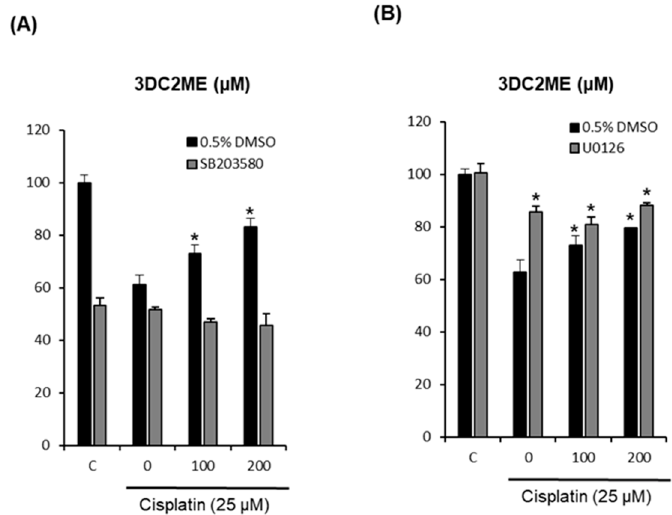
Figure 5. Effects of ( A ) SB203580 and ( B ) U0126 on the protective effects of 3DC2ME in cisplatin-induced cytotoxicity in LLC-PK1 cells. An MTT assay was performed on LLC-PK1 cells exposed to 25 µ M cisplatin for 24 h. Control cells were treated with the vehicle only (mean ± SD, * p < 0.05 compared to the control).